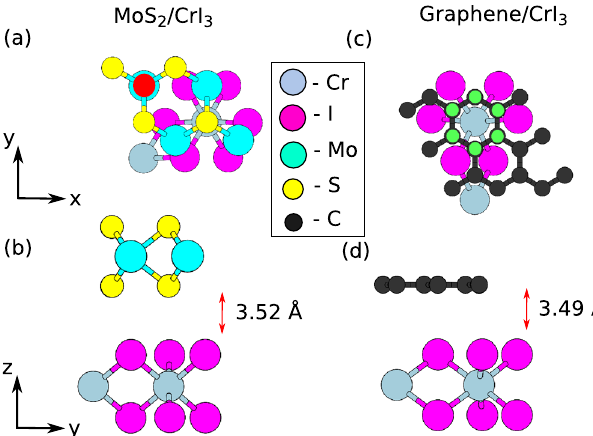
Figure 1. ( a , b ) The top and perspective view of the most stable configurations of 2:1 MoS 2 on CrI 3 respectively. The atom marked in red is the reference Mo atom with respect to which the various configurations have been named. ( c , d ) represent the same for 3:1 graphene on CrI 3 . The graphene ring with respect to which we fix the nomenclature is highlighted by the green